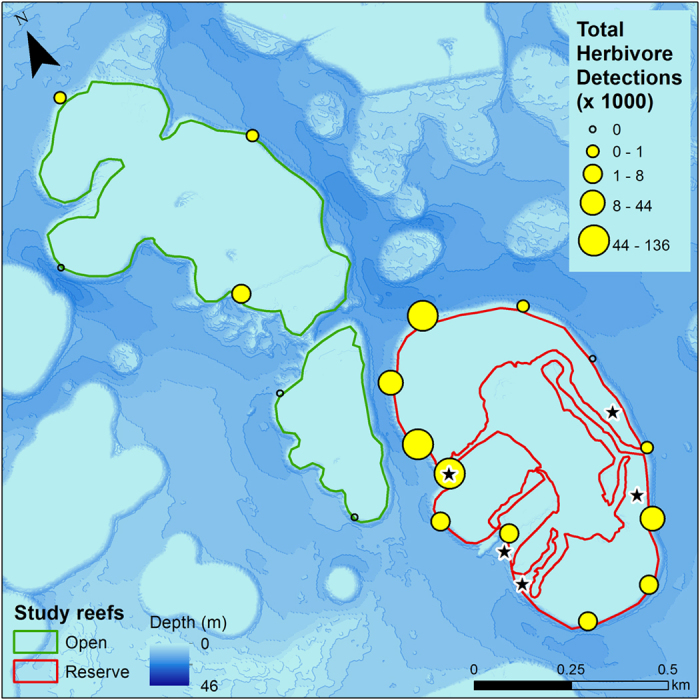
Total detections of tagged herbivorous fish for each receiver.All fish were captured in the marine reserve. Stars denote capture/release locations for tagged individuals (N = 40). Map was created using ESRI ArcMap 10.1, http://www.esri.com/software/arcgis/arcgis-for-desktop.